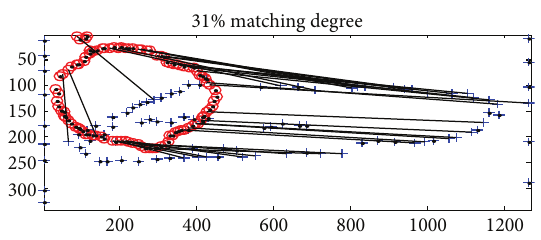
𝑥 represents the number of feature points and 𝑦 represents 60 bins. 𝑧 represents the number of pixels of each